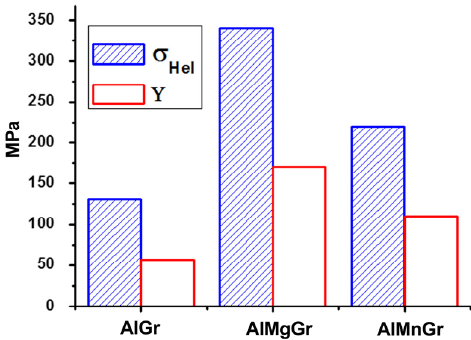
Figure 4. Dynamic properties of CG